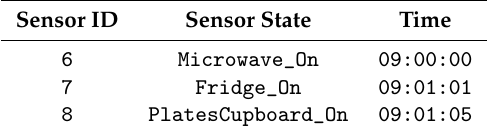
Table 3. A sample of sensor status and